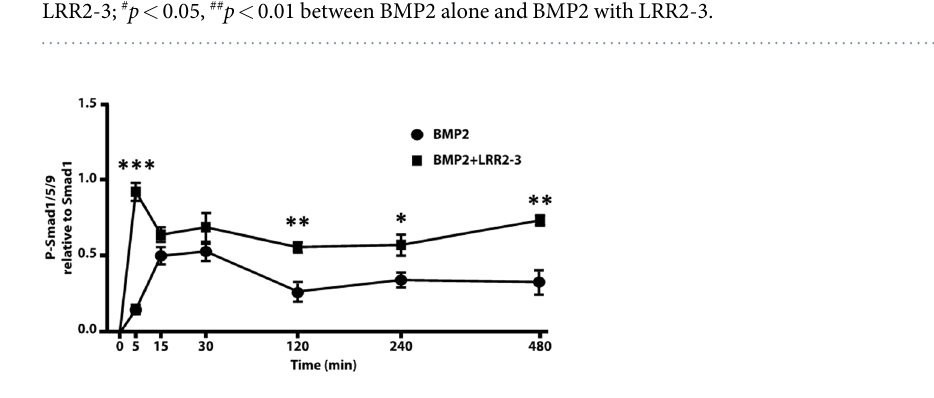
Figure 3. Effect of LRR2-3 on BMP-2 induced osteogenic gene expression in C2C12 cells. Runx2: runt-related transcription factor 2, Col1A2: type I collagen alpha 2, OCN: osteocalcin, OSX: osterix. Values are shown as mean ± S.E. (n = 3). Since the expression of OSX was detected only in BMP-2 alone and BMP-2 with LRR2- 3, the expression is shown in Ct values. * p < 0.05, ** p < 0.01 between control and BMP2 alone or BMP2 with